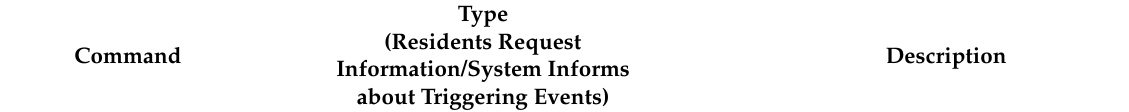
Table 4. Main voice interactions with the